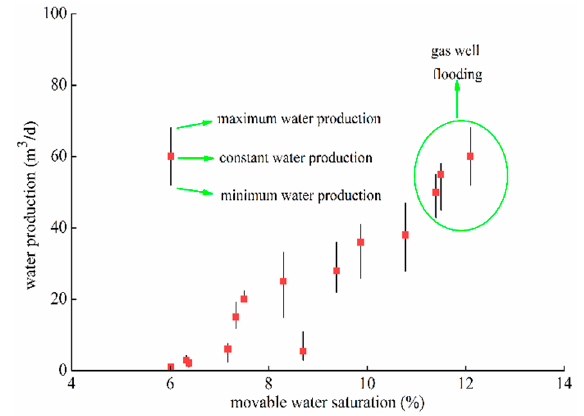
Figure 12. Water production versus movable water saturation.